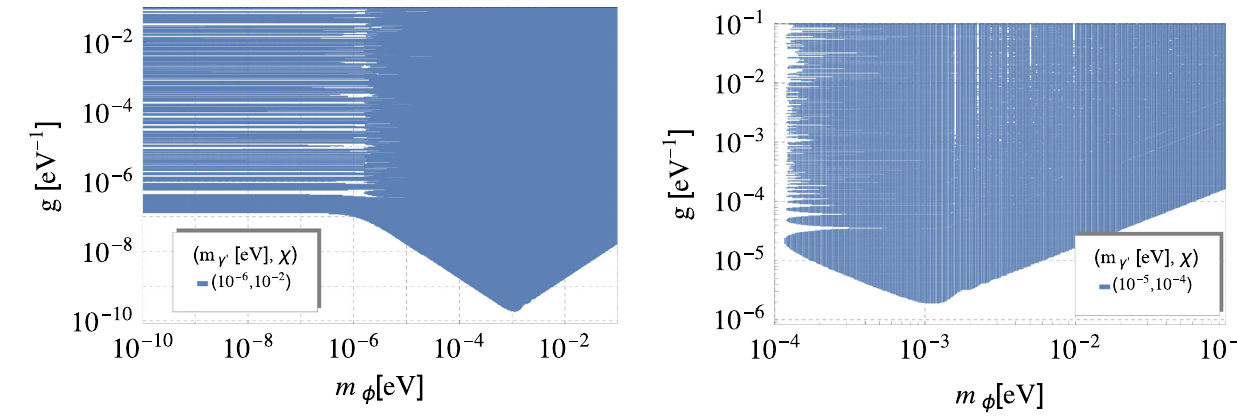
Fig. 3 Exclusion plot for the ALP using ellipticity measurements. We have taken ψ exp = 9 × 10 − 11 as suggested by the results of PVLAS [22]. Left figure: for small ALP masses the parameter g is independent of the mass (strong regime) but some gaps in sensitivity appear because the oscillation angle δ 1 > 1 for this parameter space. For m γ (cid:4) < m φ the HP has almost no effect on the ellipticity angle, so the ALP gets more